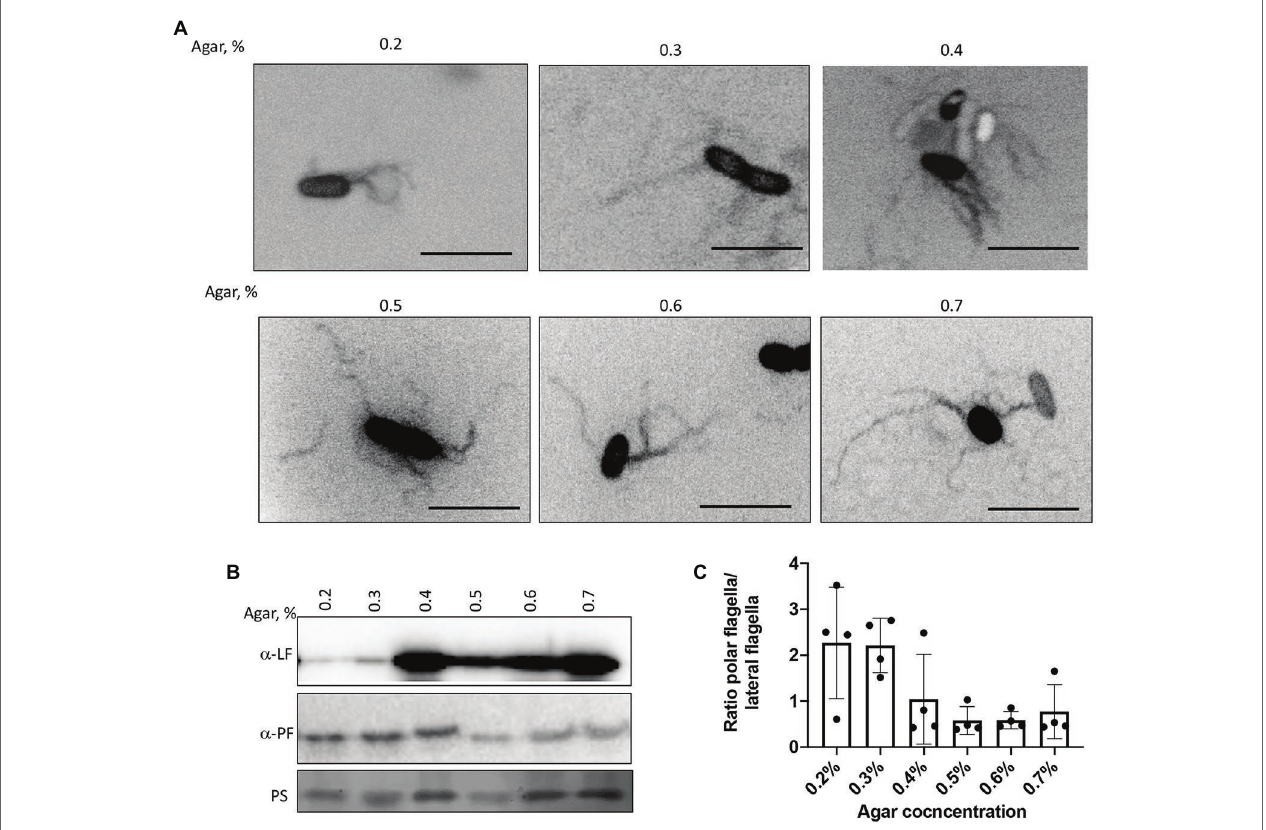
FIGURE 5 | Visualization of the polar and lateral flagella in A. brasilense strains. (A) Representative images of Sp7 cells collected from the media with 0.2–0.7% agar and stained with Alexa fluor ™ 488 NHS Ester. Arrows indicate localization of the polar flagella. Images are presented as the negatives of the original images. Scale bar = 5 μ m. (B) Western blot analysis with anti-polar (1:1,000) and anti-lateral flagellin (1:1,000) polyclonal antisera of whole-cell preparations of A. brasilense Sp7 collected from the media with 0.2–0.7% agar. Ponceau staining (PS) is shown below for evaluation of loading control. (C) Ratio between polar and lateral flagellin abundance in wild type cells grown in media solidified with 0.2–0.7% (w/vol) agar. Quantitation was performed based on the Western blotting analysis p